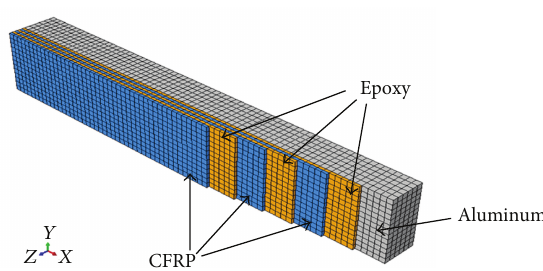
Figure 6: Schematic of a hybrid beam with three layers of